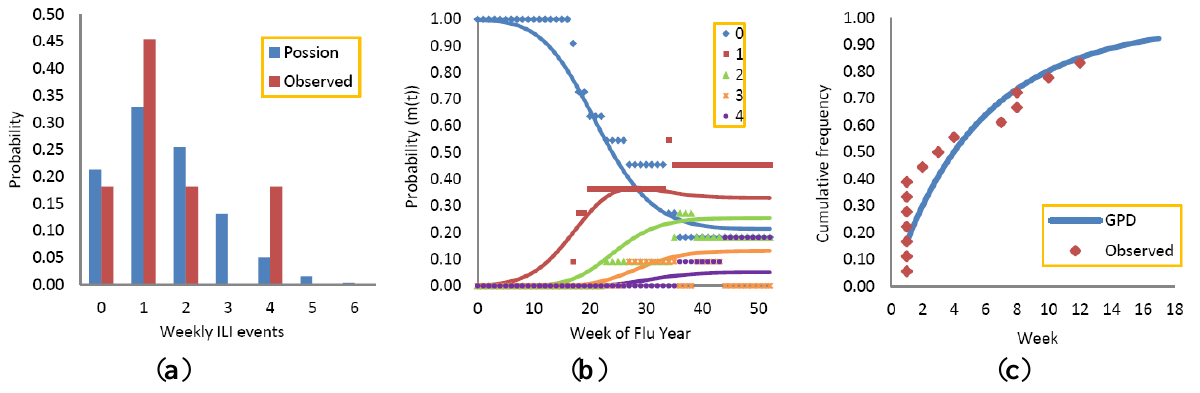
Figure 4. Annual event density, timing and duration at the 80th percentile level in Duval County. ( a ) Annual event density. ( b ) Timing plots. The probabilities of zero, one, two, three and four events having occurred, in Duval County, up to any week during the flu year. ( c ) The duration of peak events. GPD, generalized Pareto